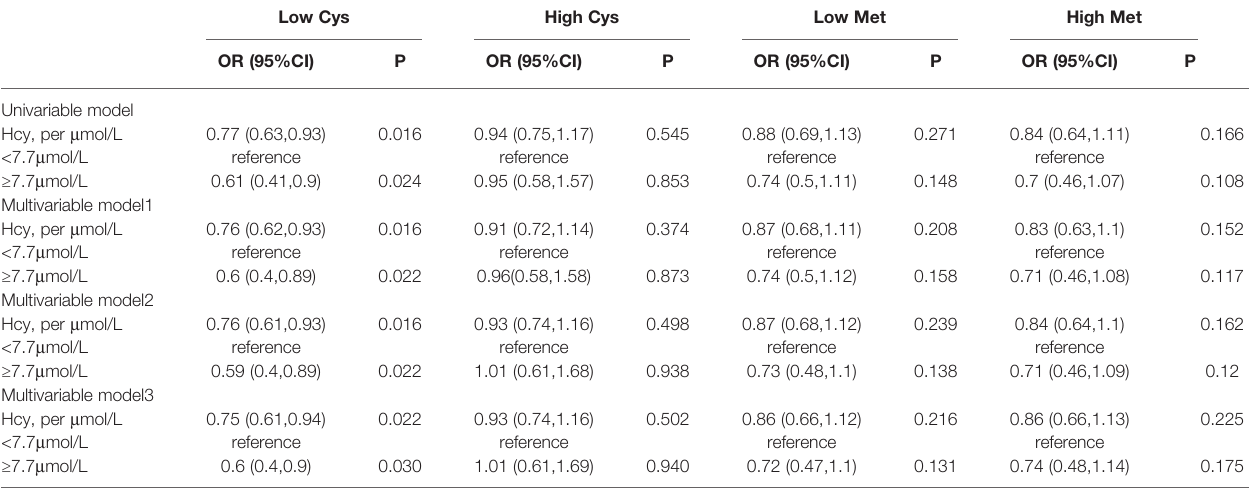
TABLE 3 | Odds ratio of Homocysteine (Hcy) for the risk of diabetic retinopathy in different group by Met and Cys.